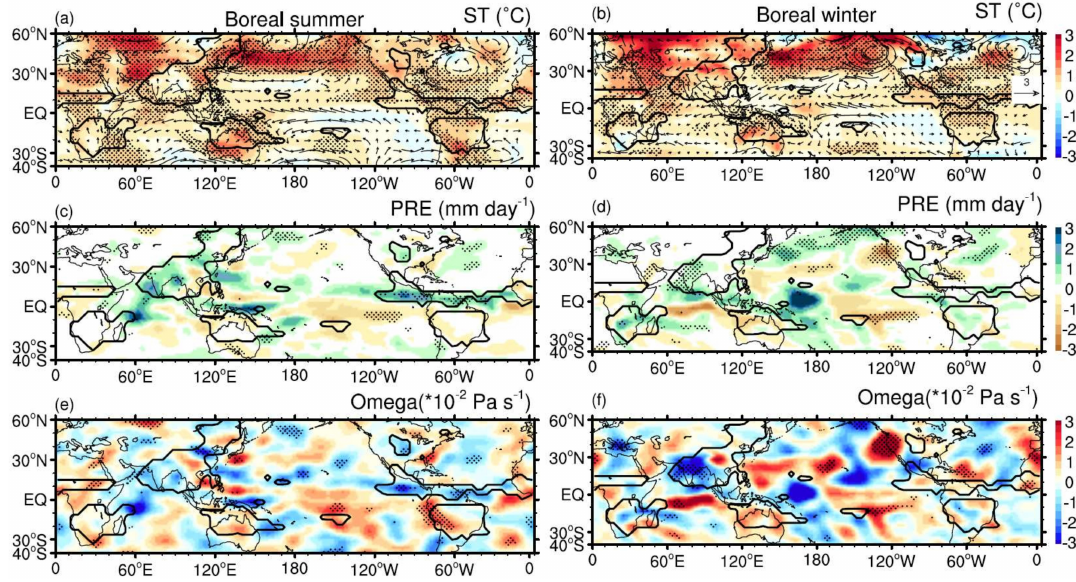
Figure 9. Horizontal distributions of surface temperature, precipitation and circulation changes. Shown are the spatial patterns of the change of surface temperature (shading) and the change of 850-hPa wind (vector) in ( a ) boreal summer and ( b ) boreal winter under the volcanic forcing (PWP minus LIA). Precipitation and circulation changes are also shown in ( c , e ) boreal summer and ( d , f ) boreal winter. Each field is scaled to have the same global-mean temperature anomaly (PWP minus LIA) as the full forcing. Statistical significance (10% significance level) based on t -test is indicated by black